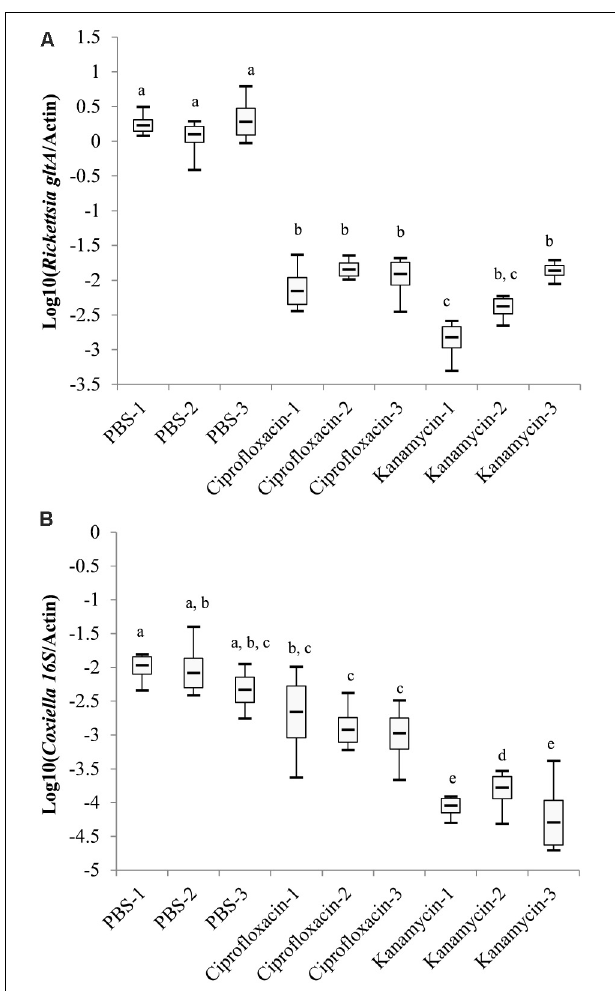
FIGURE 2 | Log-transformed relative density of Coxiella -LE (A) and Rickettsia -LE (B) in R. haemaphysaloides larvae from the antibiotic- or PBS-treated groups (Groups with the same letters showed no statistical significance in pairwise comparisons).